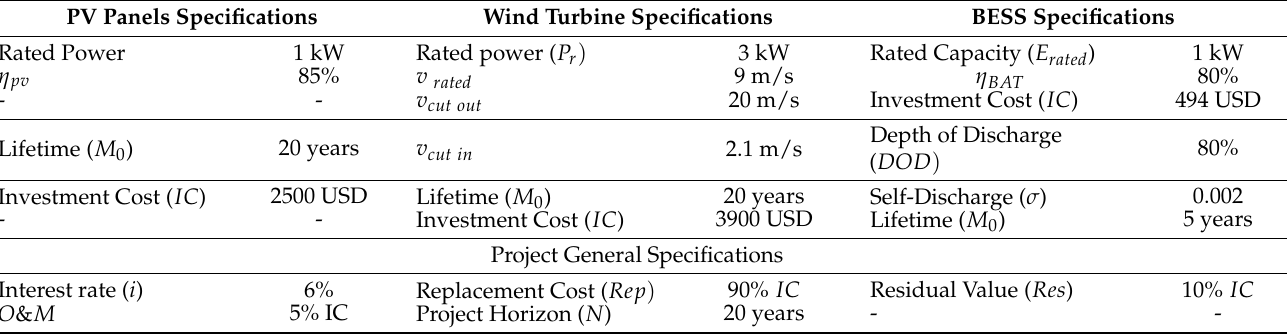
Table 2. Project and components specifications